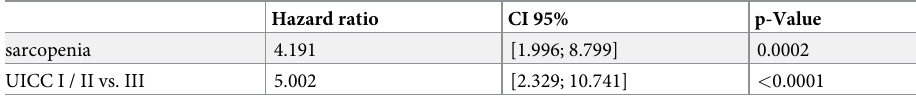
Table 6. Risk factors for survival; multivariate Cox regression